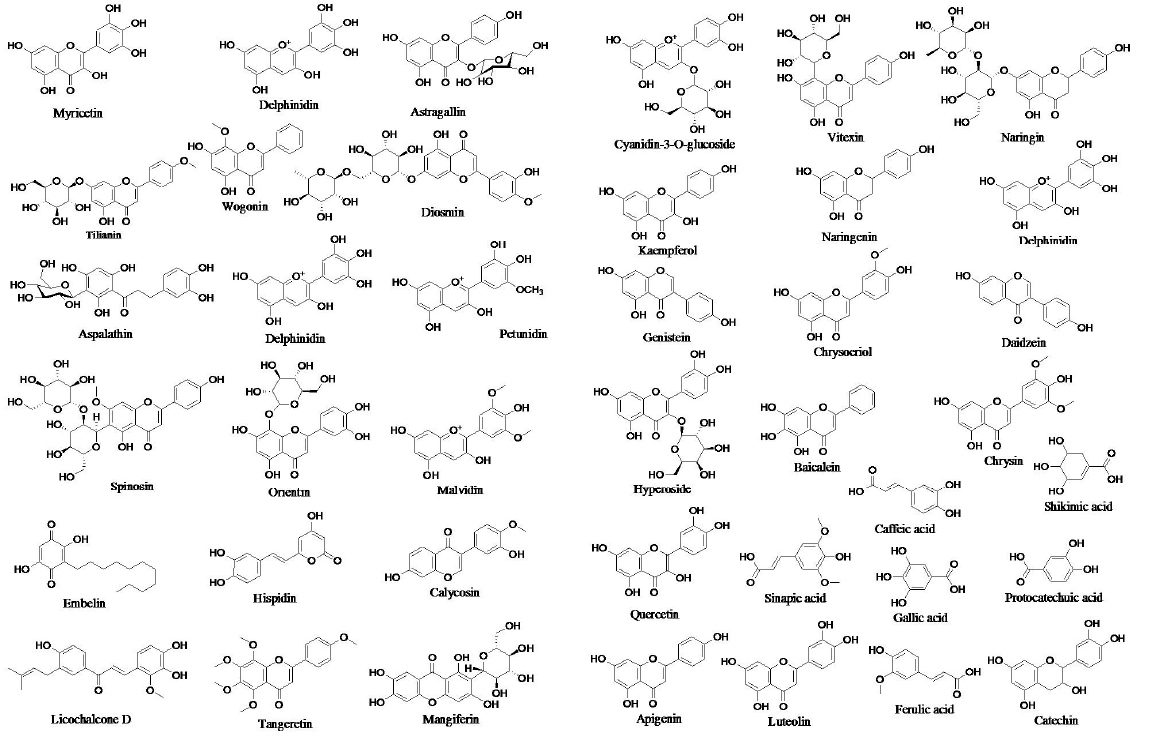
Figure 2. Structures of prototype